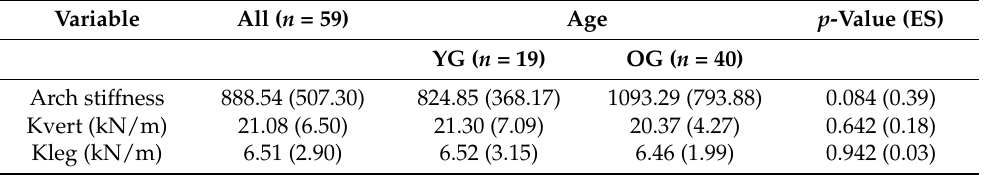
Table 2. Between-group (YG vs. OG) comparison in static (i.e., arch stiffness) and dynamic measures (i.e., vertical and leg stiffness) of lower-limb stiffness ( ± SD). Variable All ( n = 59)